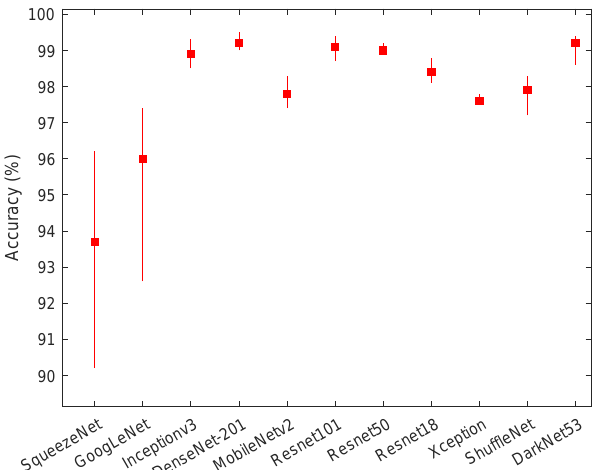
Figure 6. The mean, minimum, and maximum accuracy for all algorithms over 10 randomized runs and 70/30 data split.